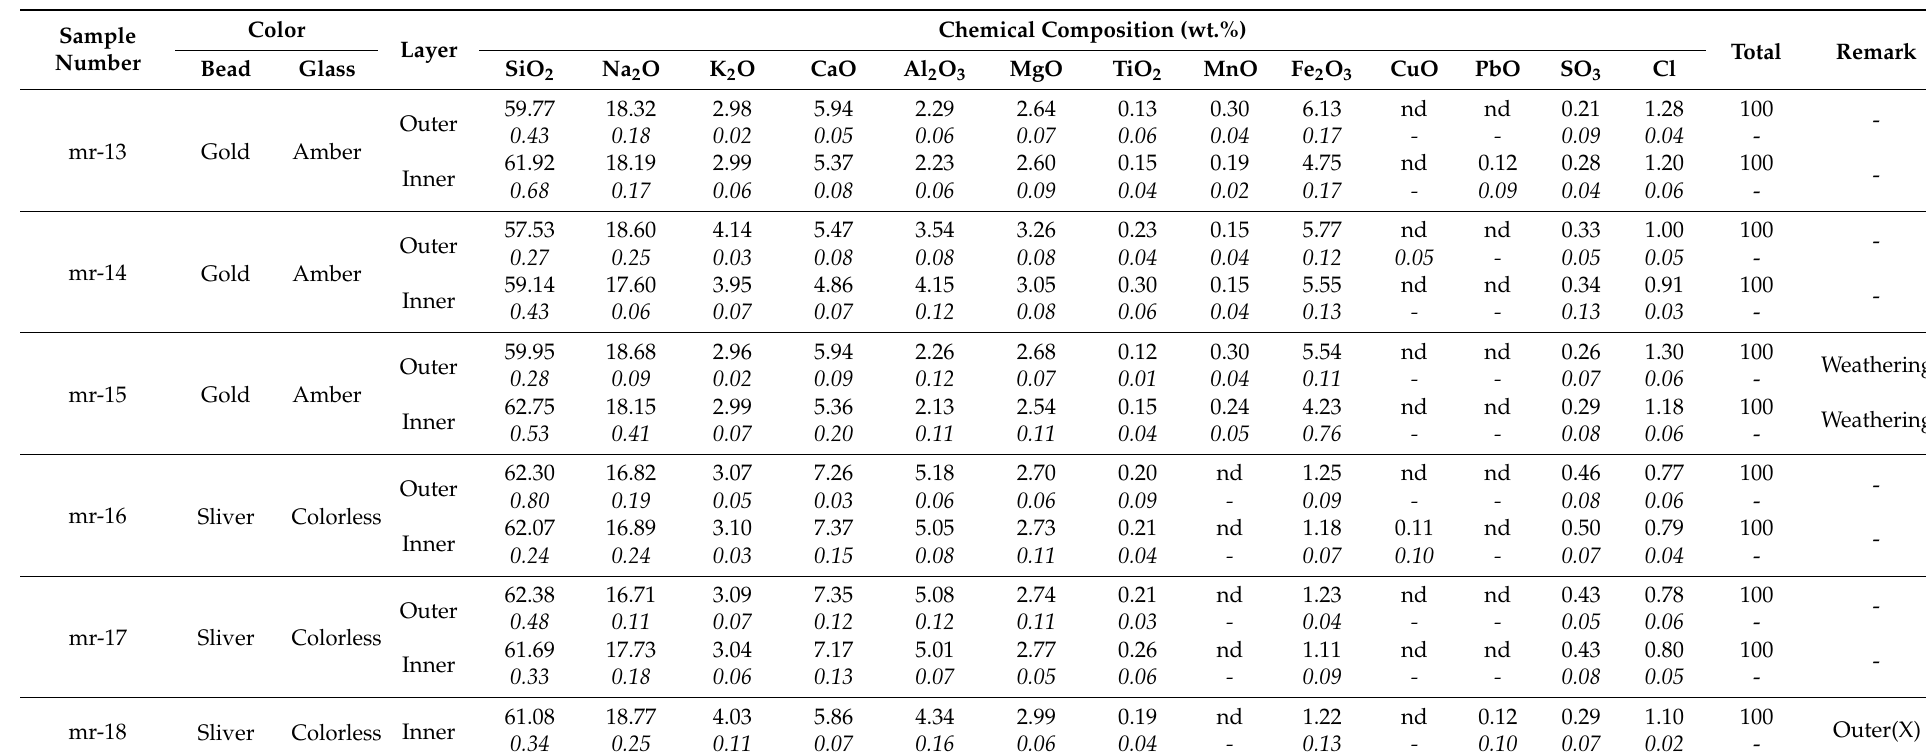
Table 3. SEM-EDS analytical results of the glass layer of silver foil glass beads excavated from the Tomb of King Muryeong in